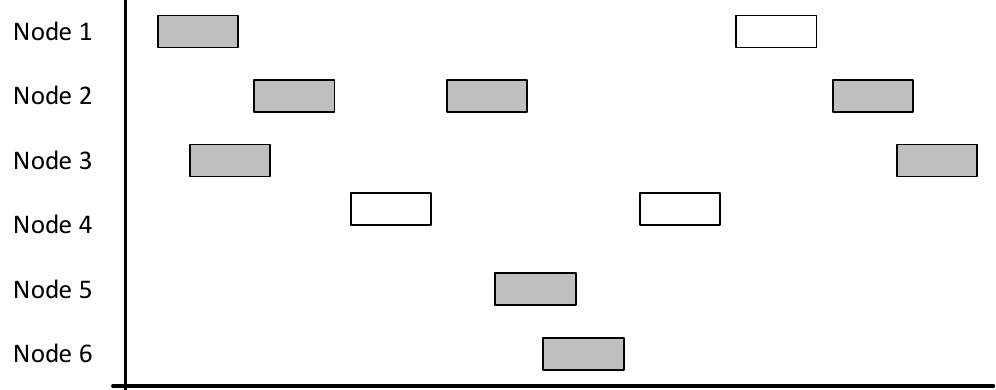
Figure 4. Diagram demonstrating a network using the ALOHA protocol with grey boxes indicating collisions and overlapping. White boxes indicate successful communication.